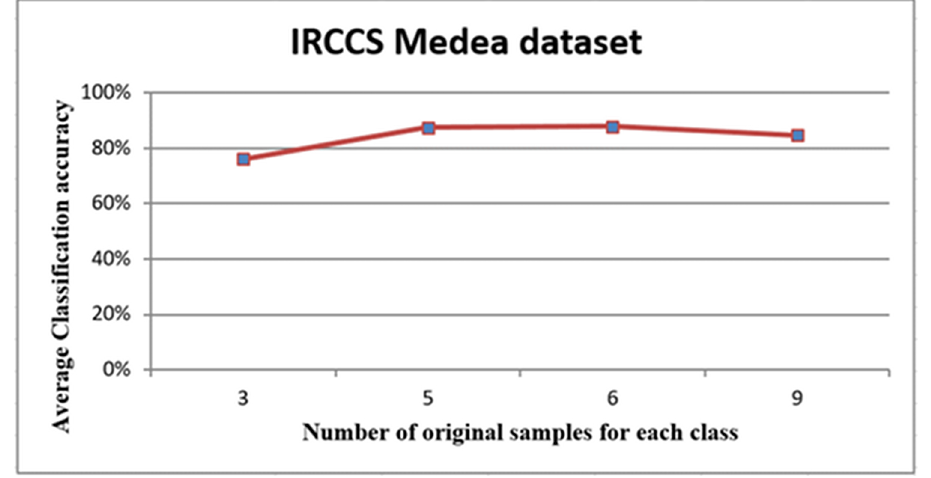
Figure 7. The curve of the average accuracies of the simulated datasets.